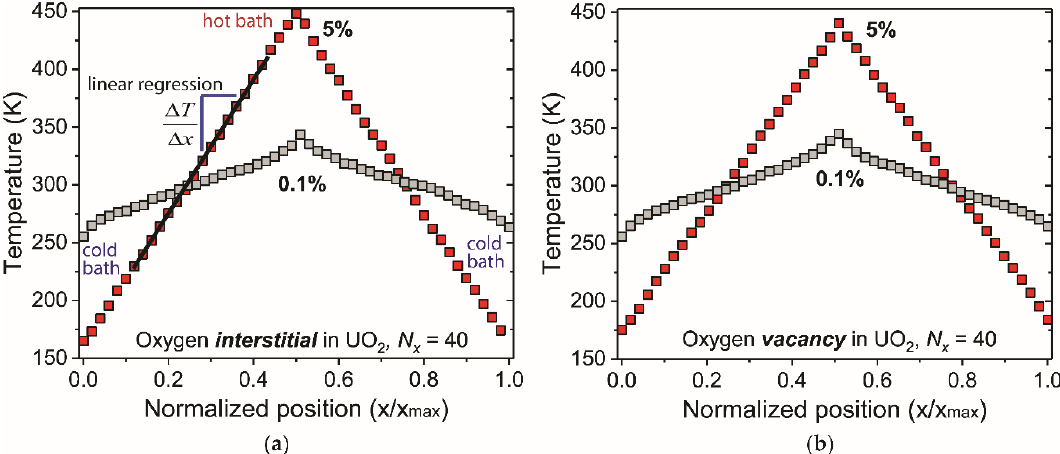
Figure 4. Representative temperature profiles during RNEMD. ( a ) The temperature profiles of UO 2 with 0.1% and 5% oxygen interstitials. The black line on the temperature profile of 5% interstitial defects indicates the linear regression line used for determining the temperature gradient for the thermal conductivity calculation. ( b ) The temperature profiles of UO 2 with 0.1% and 5% oxygen vacancy